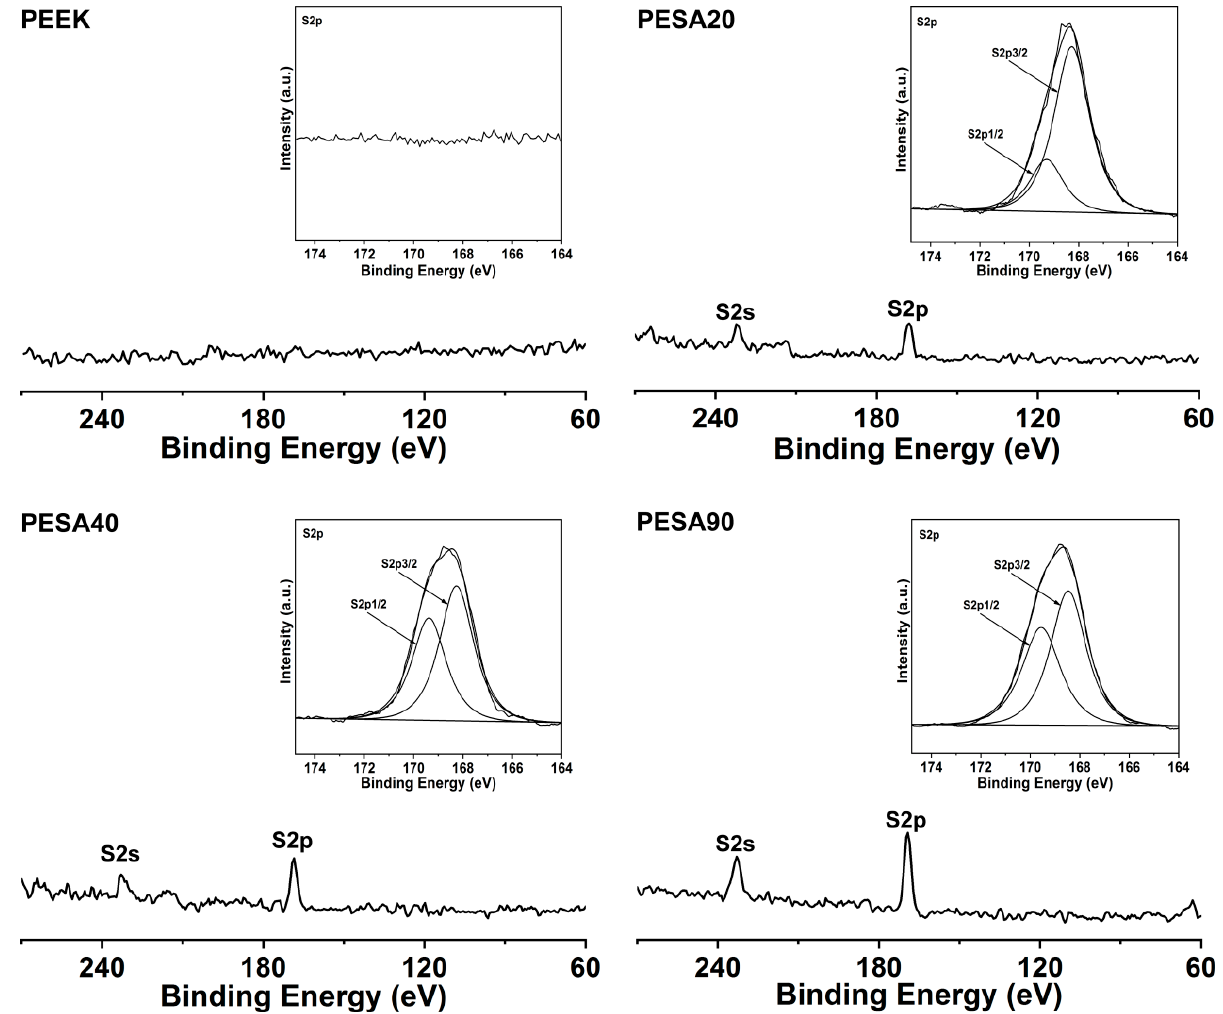
Figure 1. XPS survey spectra and the corresponding S2p high-resolution XPS spectra of PEEK, PESA20, PESA40, and PESA90.